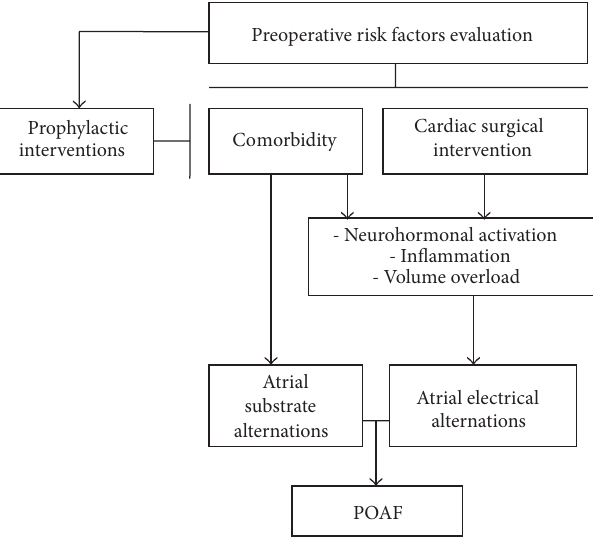
Figure 1: Schematic illustration of several factors that contribute to POAF. (postoperative atrial fibrillation =